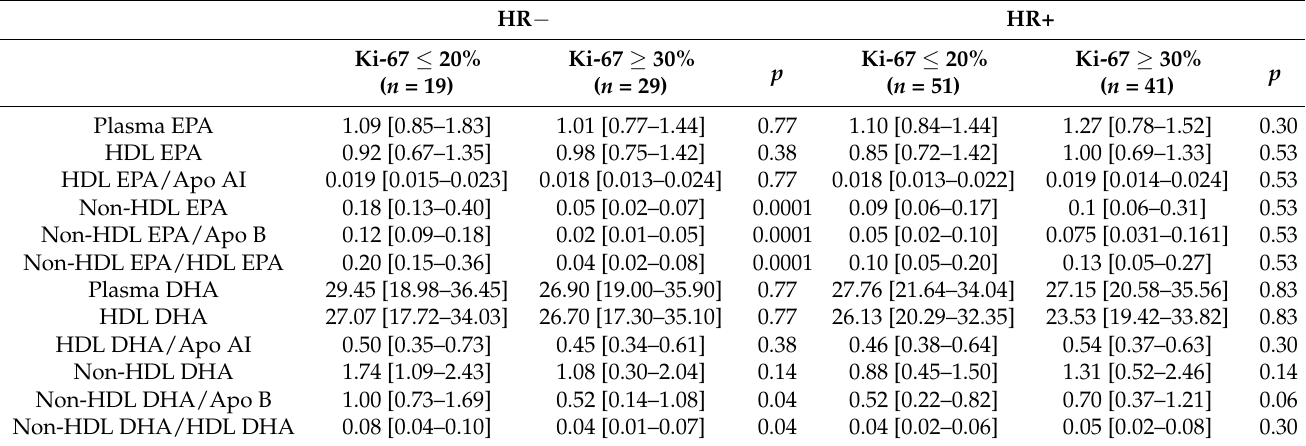
Table 3. Plasma and lipoprotein fatty acids (mmol/L) and molar ratios with apo A-I (HDL) or apo B (Non-HDL) according to the subgroups of